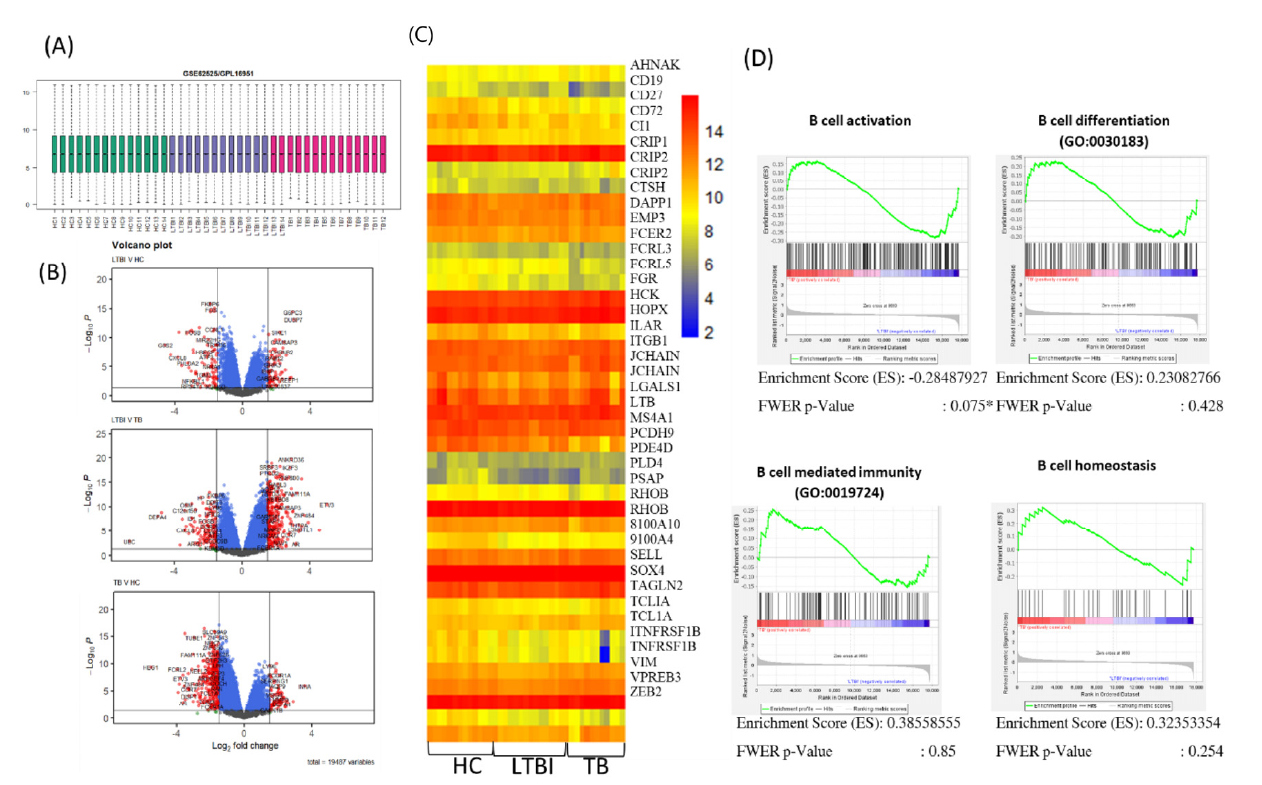
Figure 7. Gene expression and GSEA analysis revealed no significant change related to B cell signature. ( A ) Pre-processing and normalization of DNA microarray data shows the distribution of microarray after normalization and explains the uniform distribution obtained after implementing normalization, i.e., removal of noise from data. ( B ) Volcano plots showing genes significantly upregulated and downregulated in different groups. Blue dots: log 2 fold change > 0, p < 0.01. Red dots: log 2 fold change > 2, p < 0.05. The black line indicates adjusted p -value threshold ( ≤ 0.05) to set statistically significant results. ( C ) Affymetrix microarray data (heatmap) reveal no significantly differentially expressed B cell signature genes in different TB groups compared to healthy controls. ( D ) GSEA on gene set using GO terms shows only significant enrichment in B cell activation in TB groups versus HD. FWER p value <